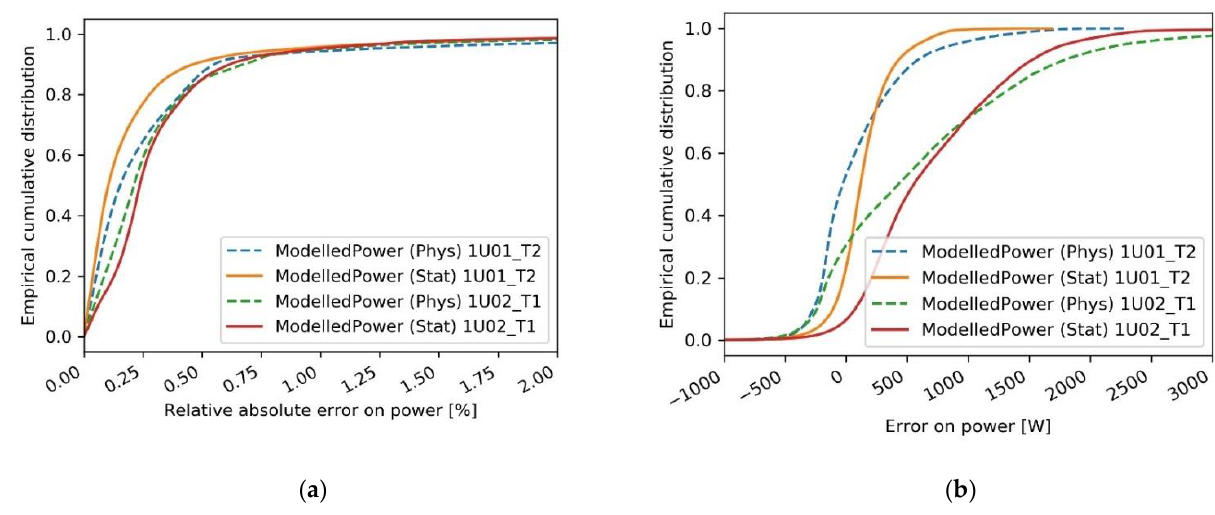
Figure 8. Empirical cumulative distribution of the relative absolute errors ( a ) and error ( b ) obtained with the modes for the maximum power point (MPP) trackers “1U01 - T2” and “1U02 - T1” .